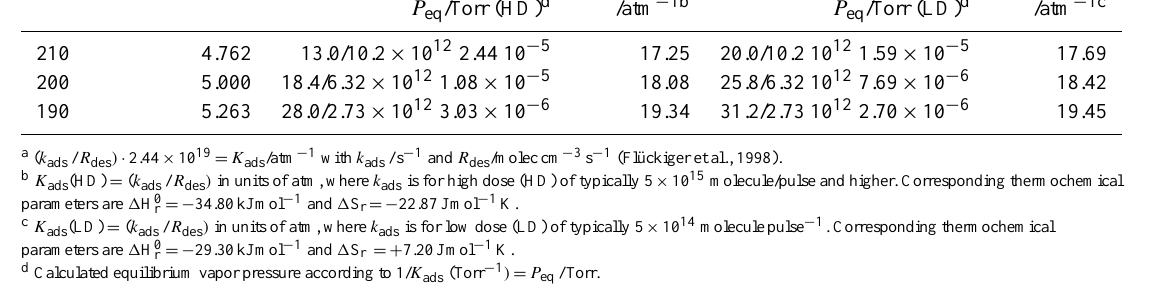
Table 6. Thermodynamic data from van’t Hoff plot for HCl evaporation of a HCl-doped H 2 O–ice condensate whose evaporation flux J ev (HCl) is displayed in Fig. 7 (data of Flückiger et al., 1998). T /K (1/ T ) · 10 3 / K − 1 K ads = k ads / R a ln K ads (HD) K ads = k ads / R a ln K ads (LD) des des P eq /Torr (HD) d /atm − 1b